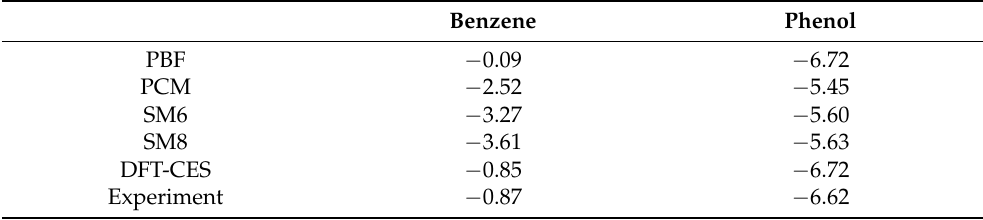
Table 2. Calculated solvation free energies ( ∆ G sol ) of benzene and phenol monomer using PBF, PCM, SM6, SM8, and DFT-CES method. The listed values are in kcal/mol. The experimental values of ∆ G sol are from the hydration dataset of a previous study about solvated binding free energies